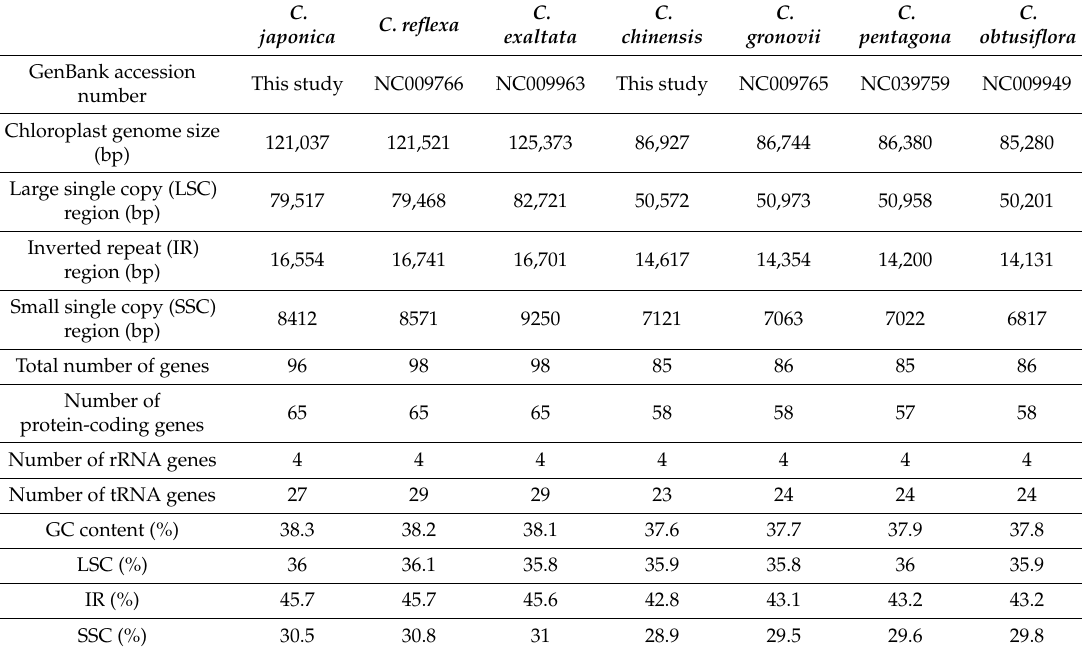
Table 1. Characterisation of the chloroplast genomes of seven Cuscuta